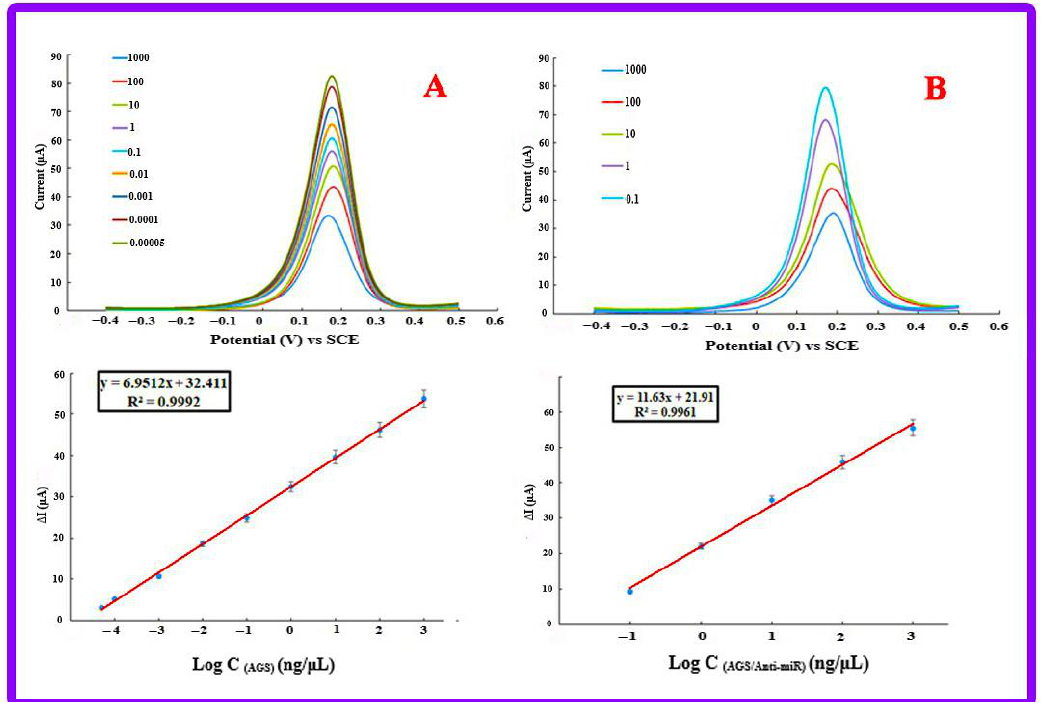
Figure 11. Electrochemical results of miRNA-21 measure changes in AGS cell line before and after treatment with Anti-miR-21. ( A ) The control group with a limit of detection 5 × 10 −5 ng/μL and the ( B ) group treated with Anti-miR-21 with a limit of detection 0.1 ng/μL.